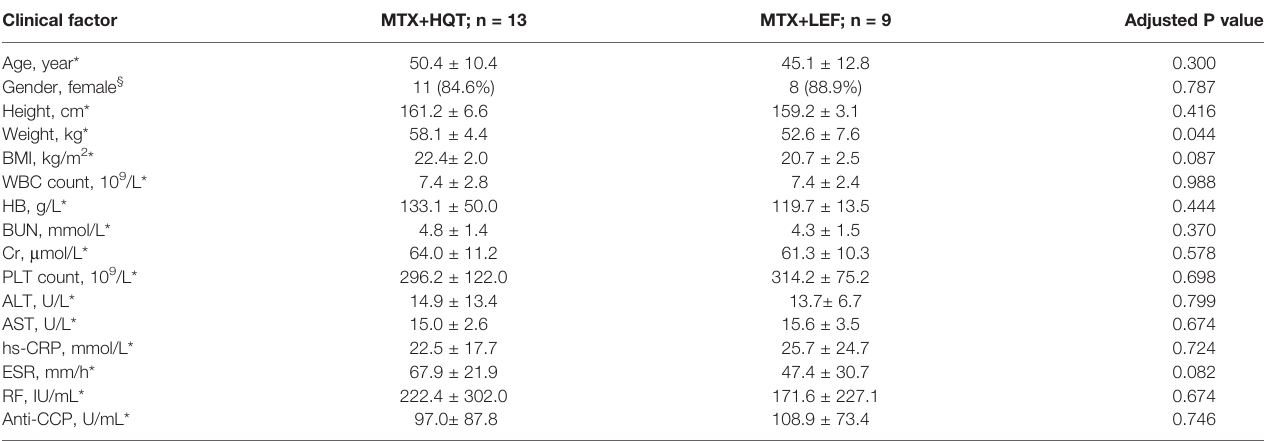
TABLE 2 | Baseline characteristics of MTX+HQT-treated (n = 13) and MTX+LEF-treated (n = 9) RA patients. Clinical factor